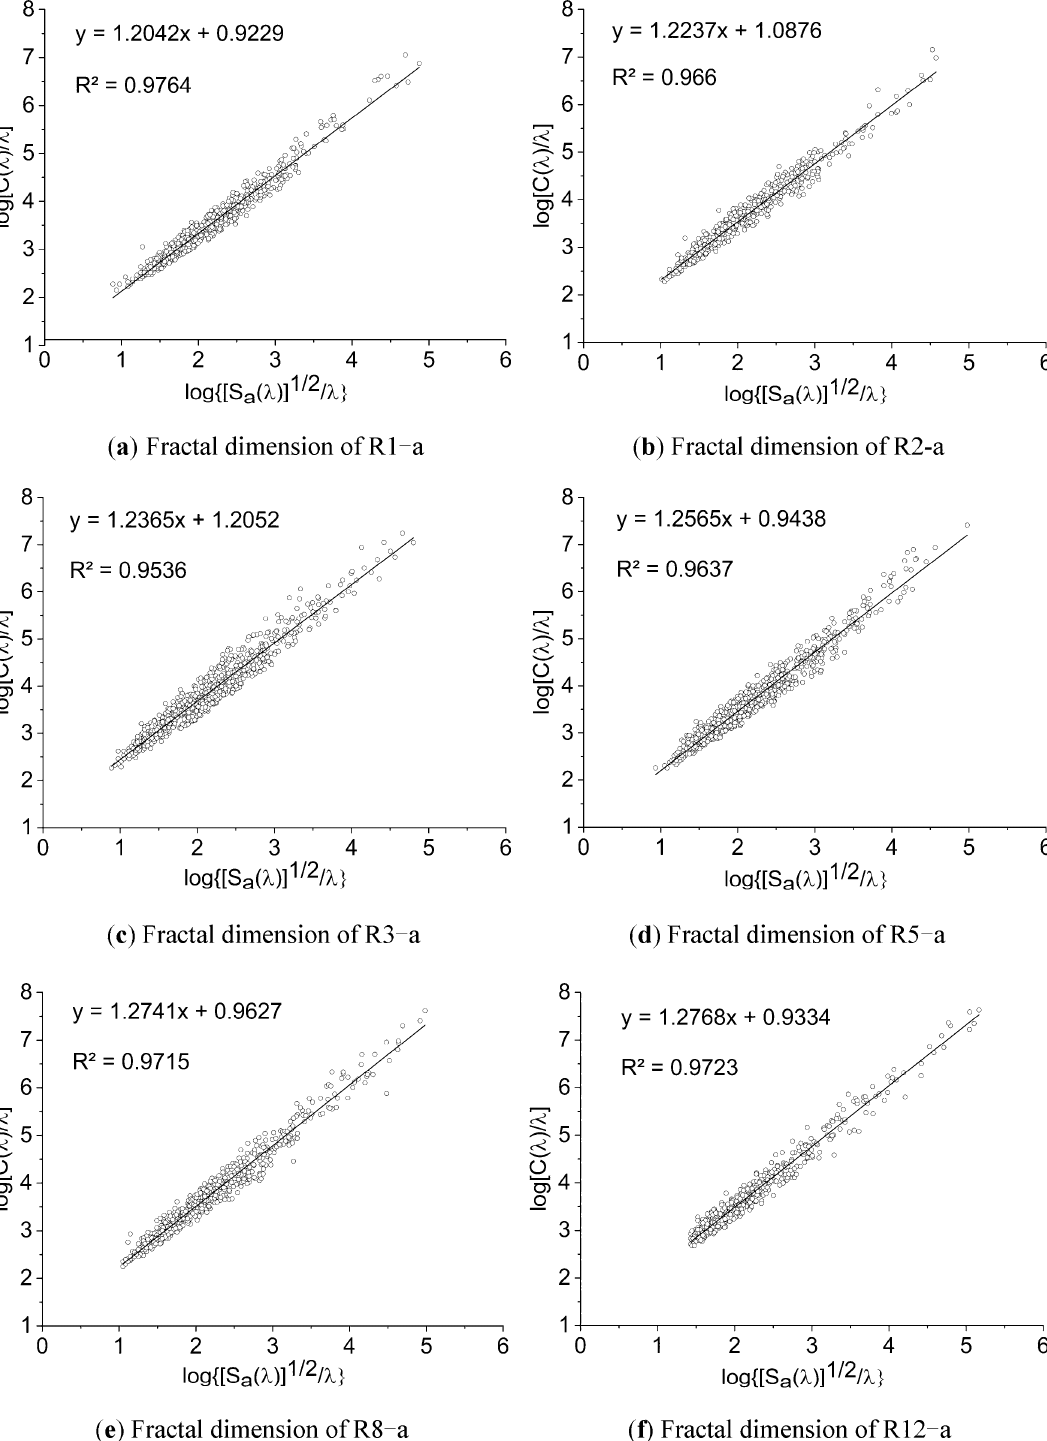
These indicate that the pores of red-bed soft rock are self-similar, so the fractal dimension can typify the fractal characteristics of the pores in red-bed soft rocks well. The pore fractal dimension curve of different samples are shown in Fig. 9. The fractal dimension of the pores of red-bed soft rocks altered from 1.20 to 1.28 as the water–rock interac- tion cycles increased, up by about 6.67% within 12 cycles. The increase of fractal dimension implied that the water–rock interaction made the pore structures more complex. That is consistent with the analysis of the pore